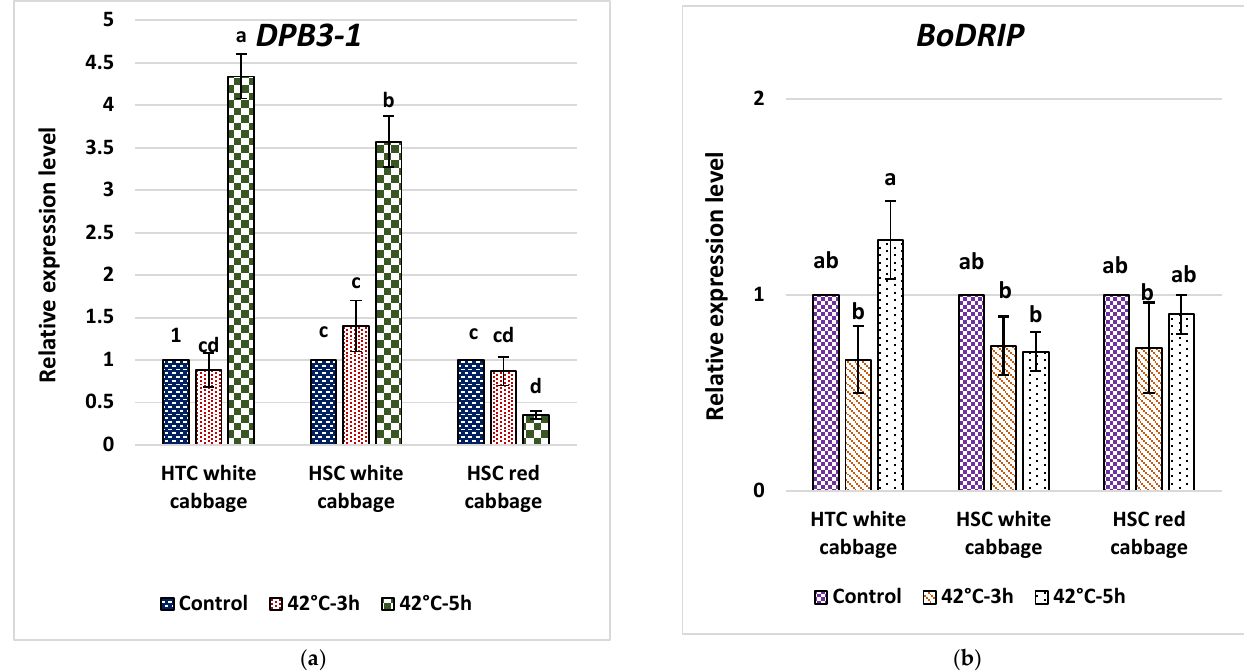
Figure 7. Expression pattern of key heat-stress response transcriptional regulators, ( a ) BoDPB3-1 and ( b ) BoDRIP , in red cabbage compared to heat-tolerant and -sensitive cabbage cultivars. Four-week-old plants were HS treated at 42 °C for 0, 3 and 6 h. The expression levels at 0h were defined as 1.0 and non-stress condition (control). Bars denote the mean ± SE ( n = 3). Mean values within each cultivar with different letters are significantly different based on Tukey’s HSD test at p < 0.05.